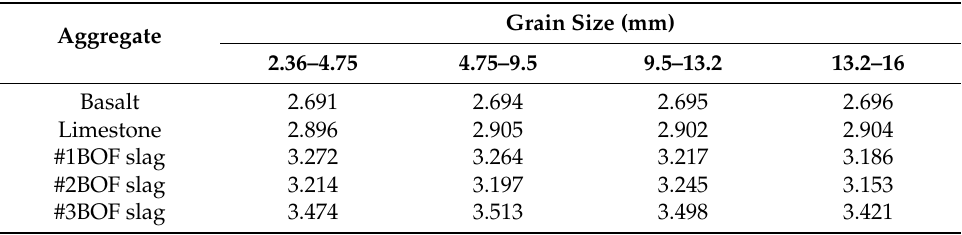
Table 6. Dse of aggregates at different grain size range.